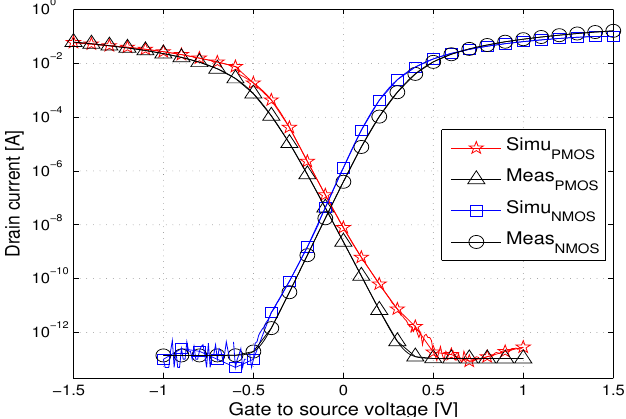
versus V curves at 200 ◦ C, V D GS